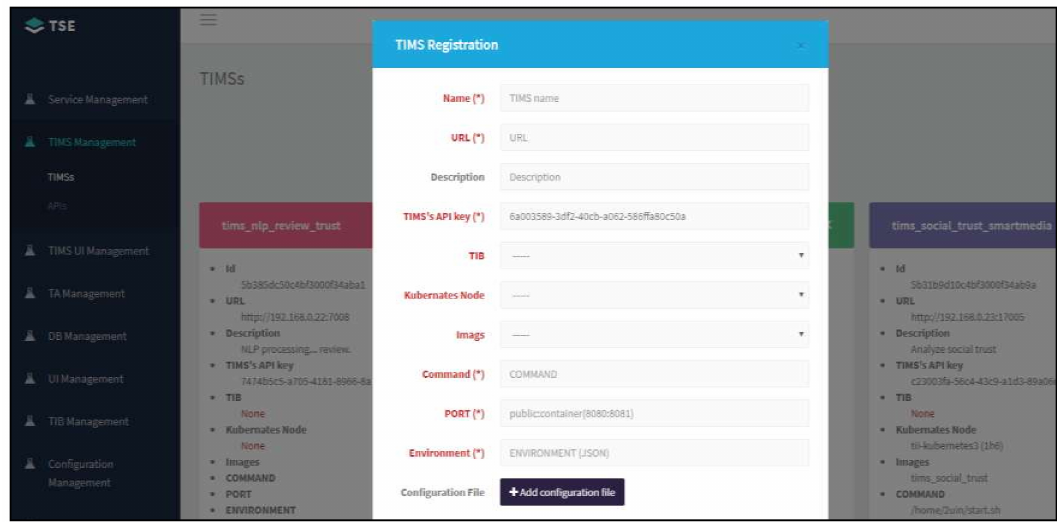
Figure 8. Trust service enabler (TSE) implementation for registering trust